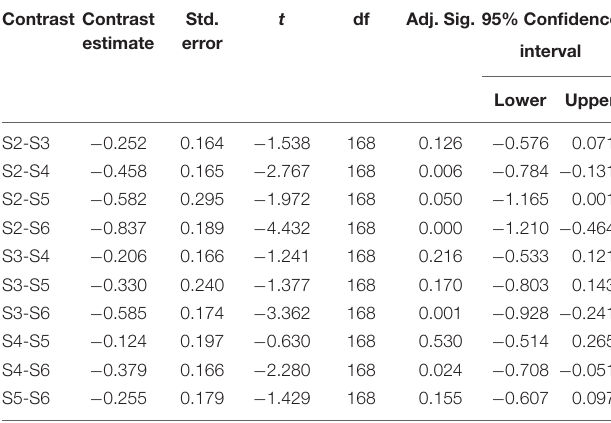
TABLE 2 | Post hoc LSD contrasts of the marital happiness scale.